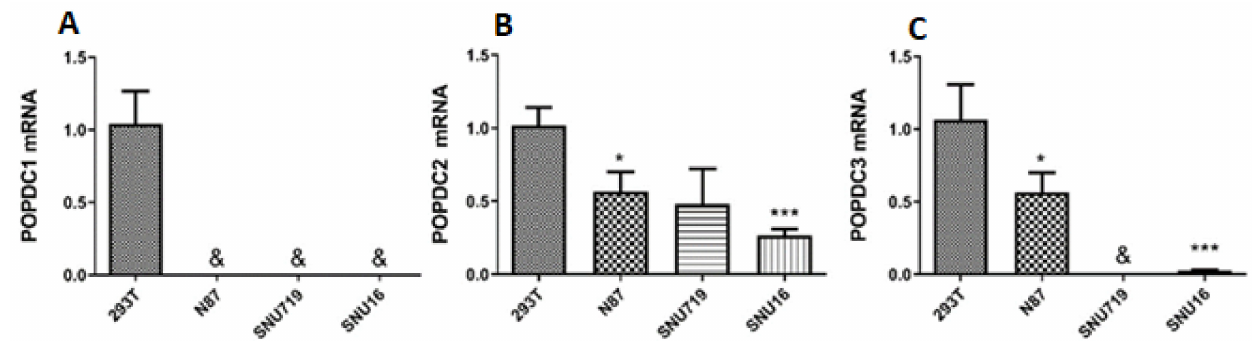
Figure 3. Expression of POPDC genes in three GC cell lines. Results are presented as fold difference from 293T reference cells. ( A ) POPDC1 ; ( B ) POPDC2 ; ( C ) POPDC3 . Mean ± SEM; * p < 0.05 vs. 293T cells; *** p < 0.001 vs. N87 cells; &, below